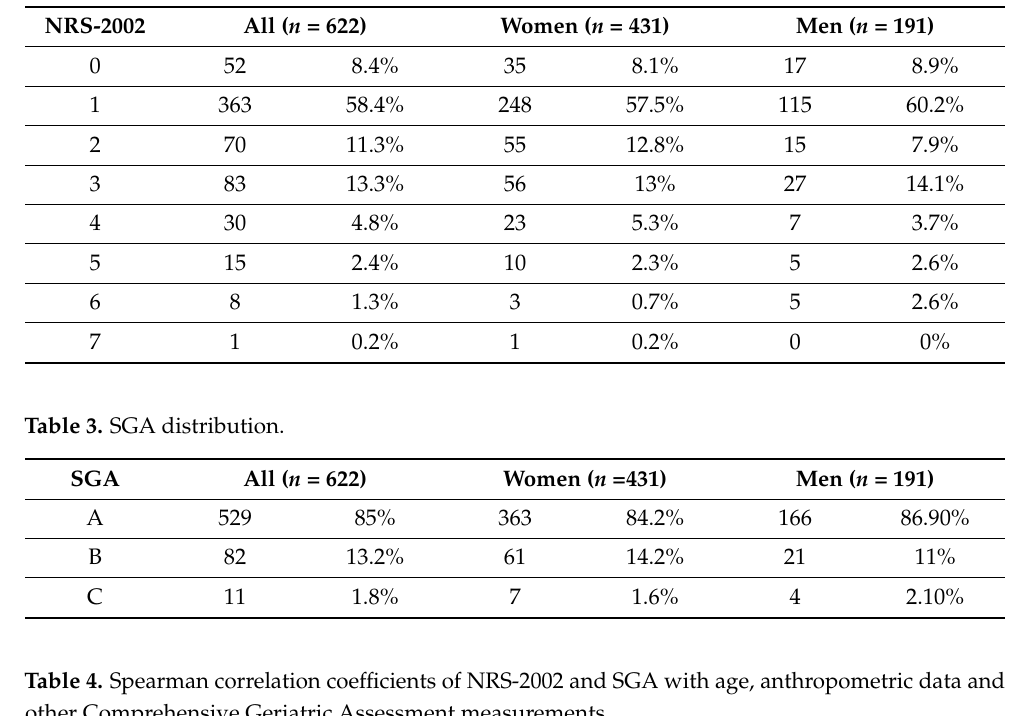
Table 2. NRS-2002 distribution.